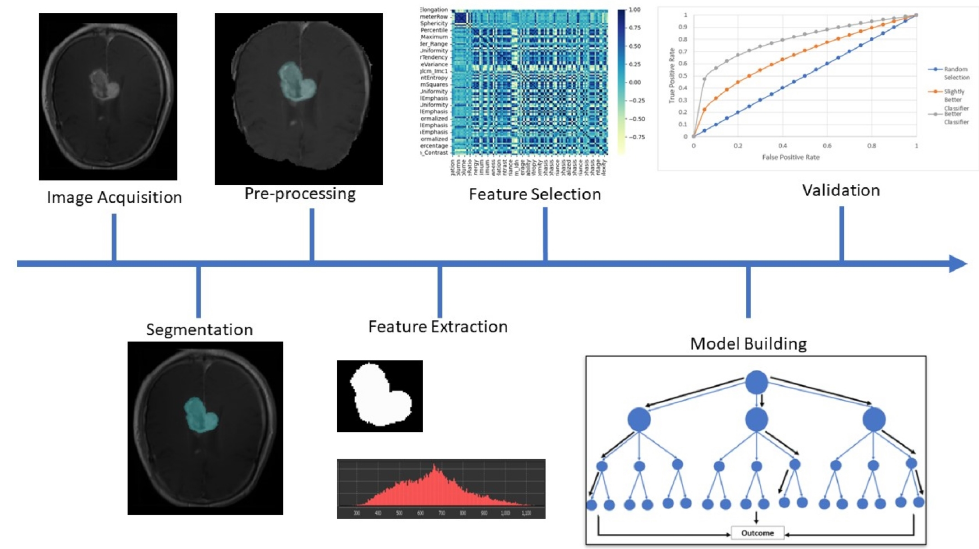
Figure 1. A scheme representing the process of developing a radiomics model. (1) Image Acquisi- tion, (2) Tumour Segmentation, (3) Image Pre-processing and standardisation, (4) Feature Selection, (5) Statistical Model Building and (6) Statistical